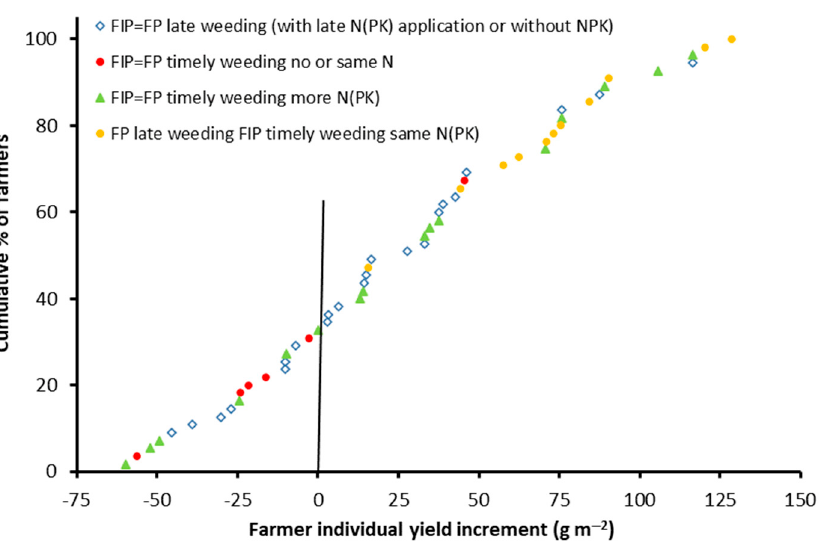
Figure 6. Farmer individual yield increment from FIP over FP for four different categories of changes in management: the blue open diamond is when FIP and FP plots were weeded late with late or no fertilization (n = 22), the red closed circle is when FIP and FP plots were timely weeded with no or the same amount of N applied (n = 6), the green closed triangle is when FIP and FP plots were timely weeded and FIP received higher N or NPK (n = 16), and the yellow closed circle is when FP was weeded late and FIP was timely weeded while the same N or NPK amount was applied between FP and FIP (n = 11).